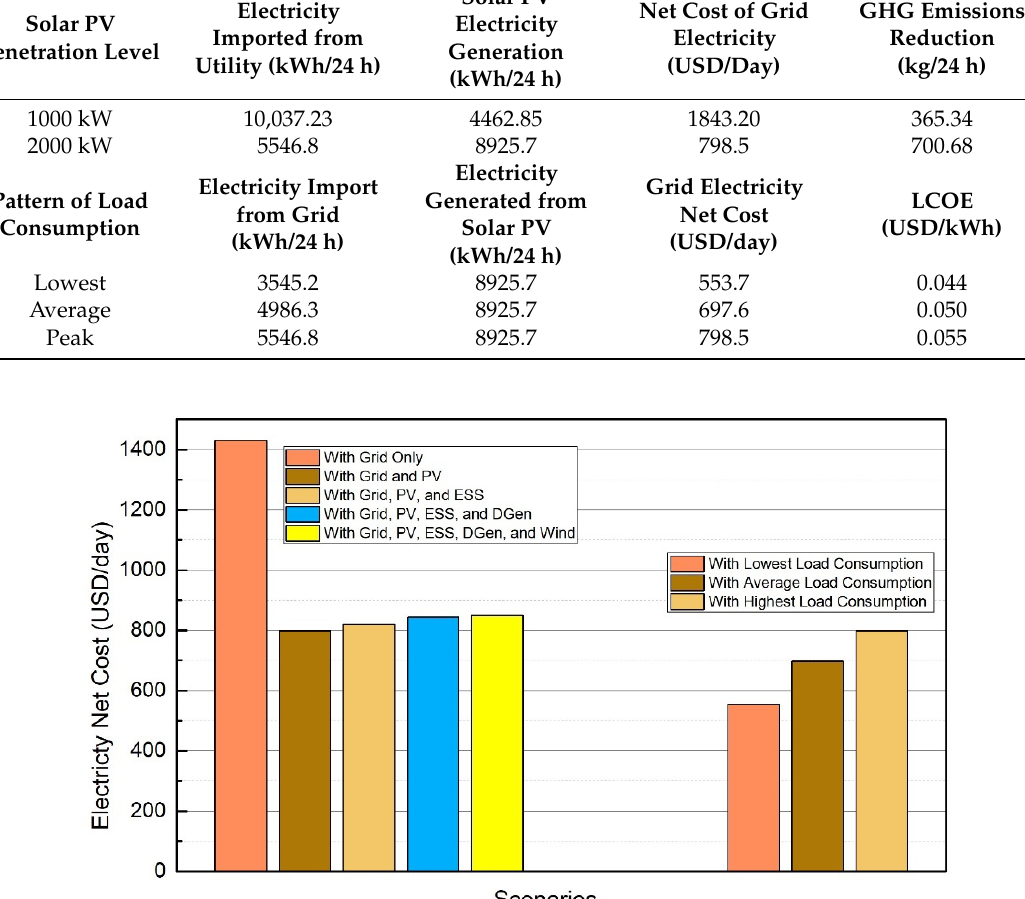
Table 6. Profile of the case studies on the grid electricity cost.